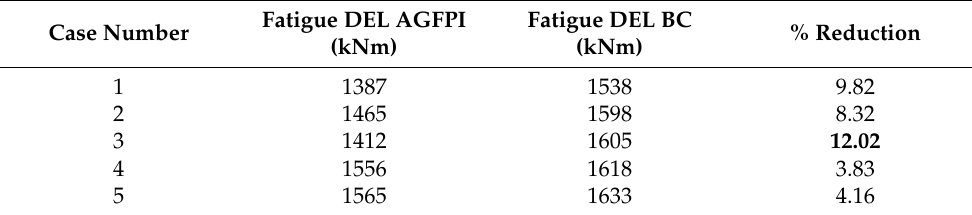
Table 5. Controller performance with respect to the blade in-plane bending moment (fatigue DEL). Case